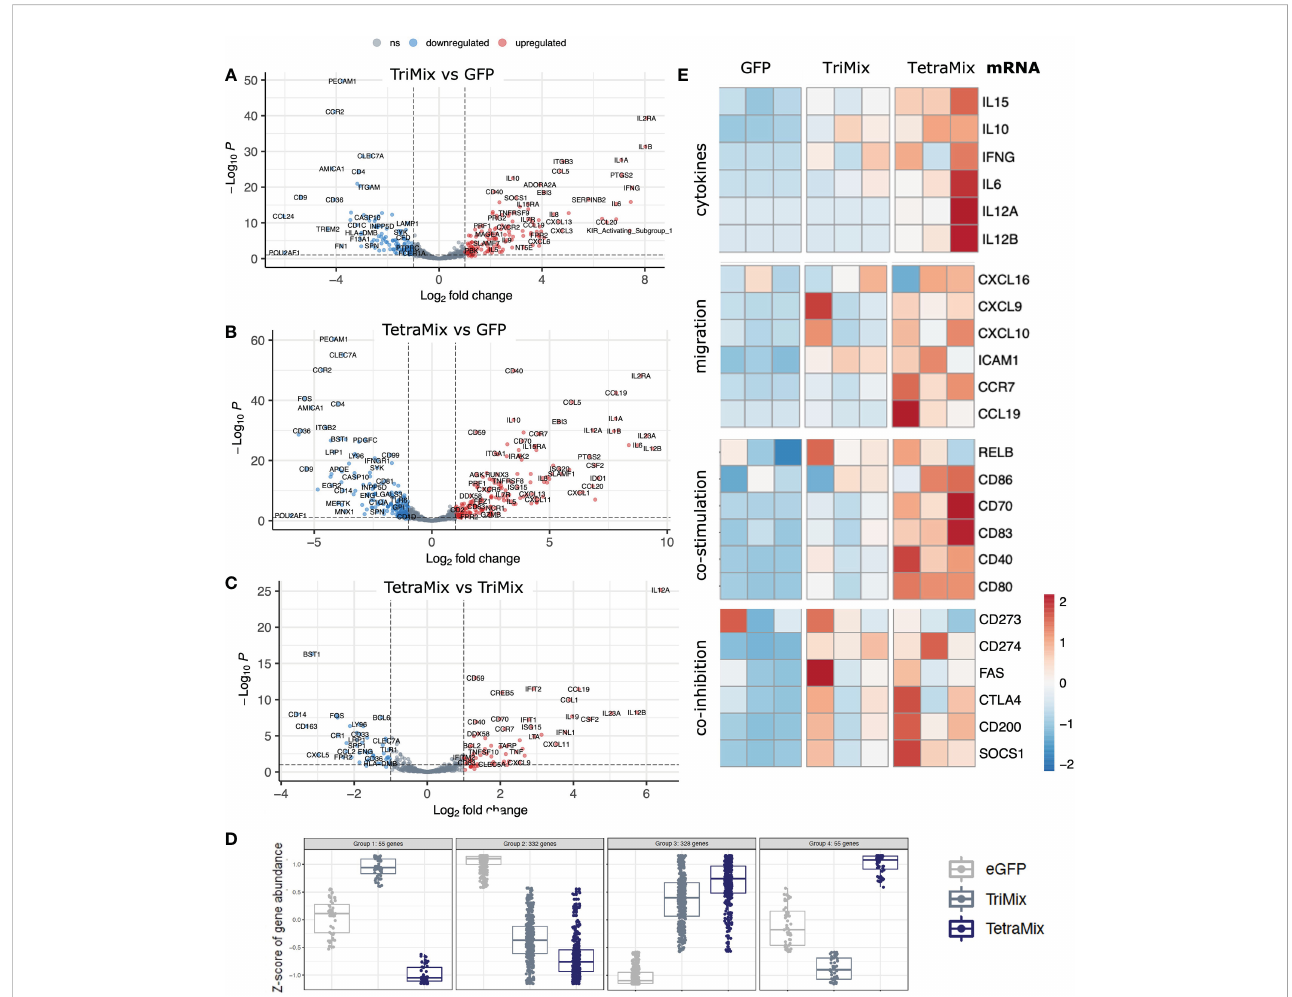
FIGURE 3 TetraMix mRNA reprogrammed DCs express genes characteristic of immunogenic antigen-presenting cells. a-c) Volcano plots displaying differential gene expression restricted to an adjusted p-value <0.1 and a log 2 fold change >2 or <-2 calculated via DESeq2 in R. (A) Differential expression of genes measured in TriMixDCs compared to the control (GFP) DCs. (B) Differential expression of genes measured in TetraMixDCs compared to the control (GFP) DCs. (C) Differential gene expression of TetraMixDCs compared to TriMixDCs. (D) Expression pattern analysis depicted in dot plots separating genes into four categories based on similarities in transcriptional changes between all three conditions. (E) Heatmaps representative of gene expression between GFP, TriMixDCs and TetraMixDCs. Gene clusters were selected based on the literature and are considered to be representative of an immunogenic antigen-presenting cell signature. These clusters include cytokines, migration, co-stimulation and co-inhibition encoding genes.